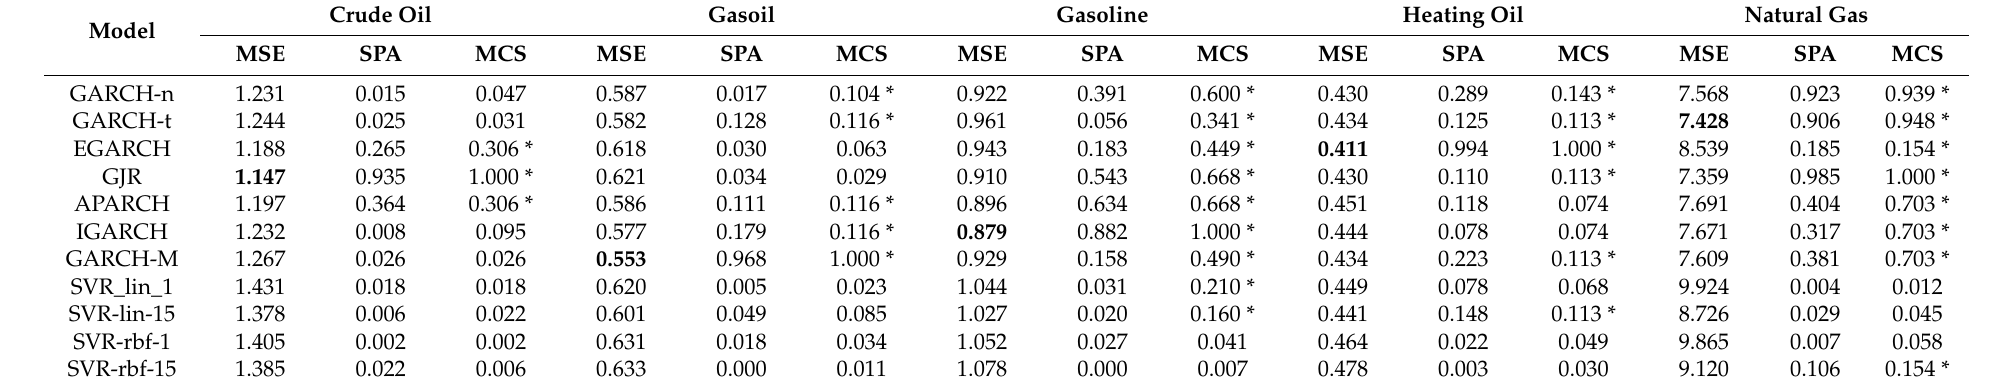
Table 4. Evaluation of the variance forecasts in terms of the MSE measure for the Parkinson estimator used as a proxy of